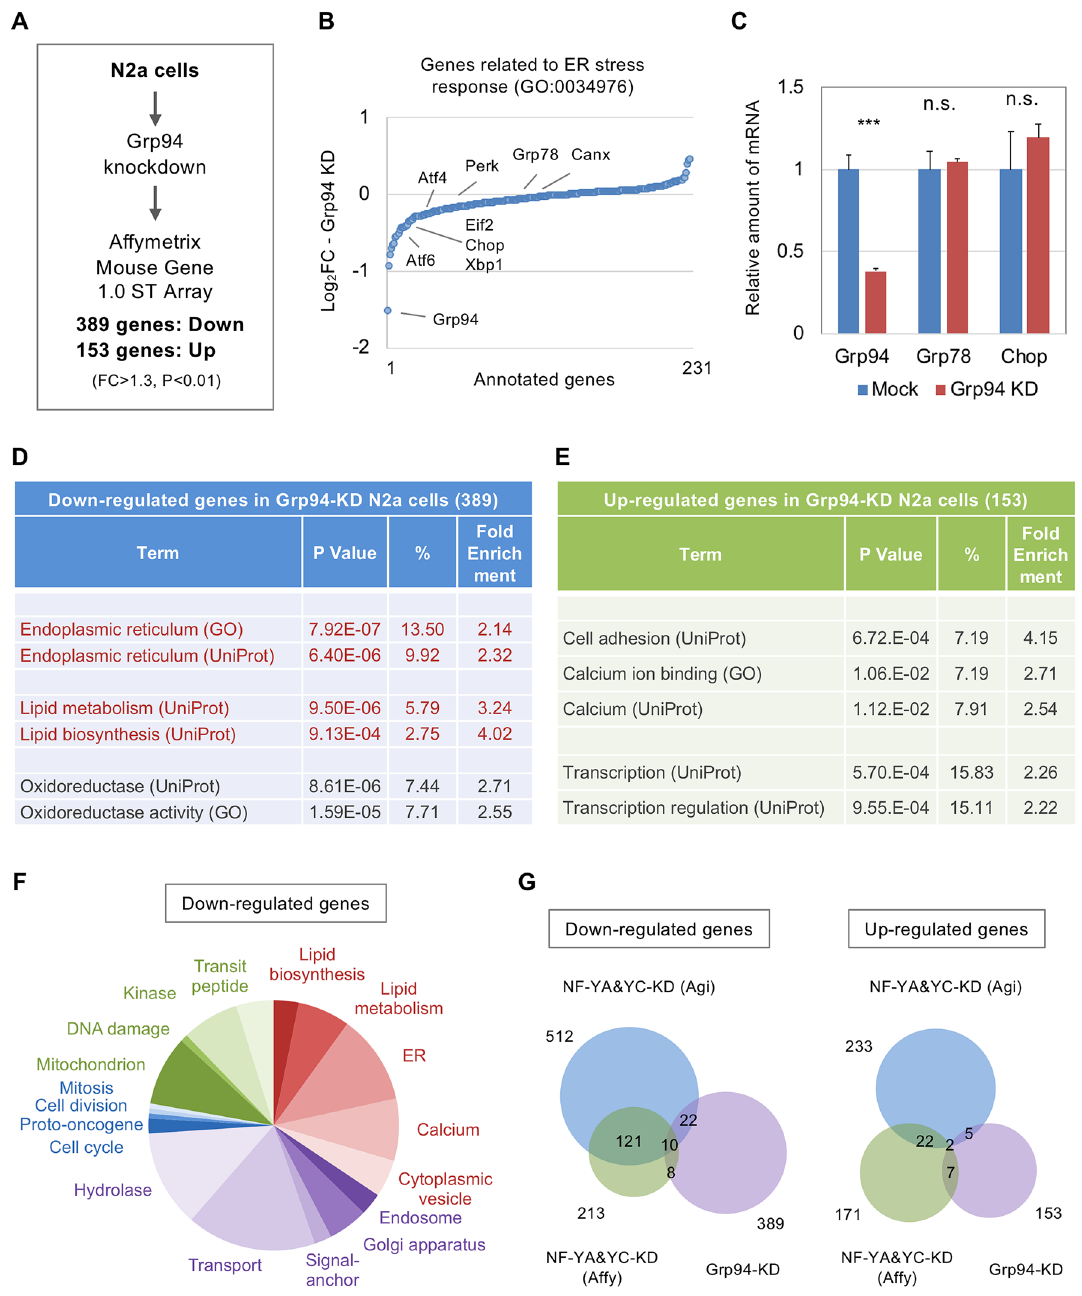
Figure 2. DNA microarray analysis of Grp94 knockdown N2a cells. ( A ) N2a cells were transfected with a knockdown vector for Grp94 or a control vector, and were processed for gene expression profiling using Affymetrix DNA microarray. Total 542 DEGs were identified, of which 389 and 153 genes were down- or up-regulated, respectively. ( B ) Log 2 FC values of the 231 genes annotated to ER stress response (GO 0034976). No distinct induction was observed for these genes. ( C ) qRT-PCR analysis of the ER stress-related genes. Values were means + s.d. of 4 data (*** P < 0.001, t-test). ( D , E ) Gene-annotation enrichment analysis for down- ( D ) or up-regulated genes ( E ) by Grp94 knockdown. P values, populations and fold enrichments were shown. Relative enrichment was observed for genes related to ER and lipid metabolism (red) for down-regulated genes. ( F ) Pie graph for the populations of annotated genes down-regulated in Grp94-knockdown cells. ( G ) Comparison of the DEGs by Grp94 knockdown with those by NF-YA and -YC knockdown. Slight overlap was observed for down-regulated